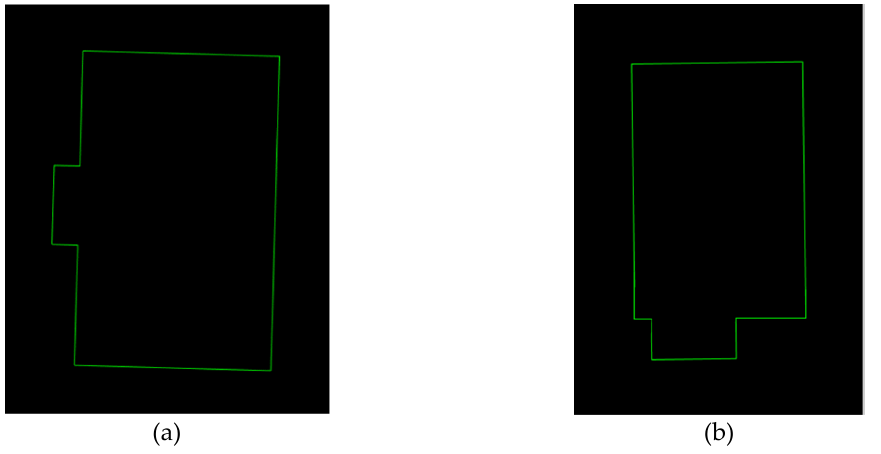
Figure 10. Border of buildings extracted by green color using ant colony algorithm. ( a ) Final rectangle of first simulated border and ( b ) final rectangle of second simulated border.